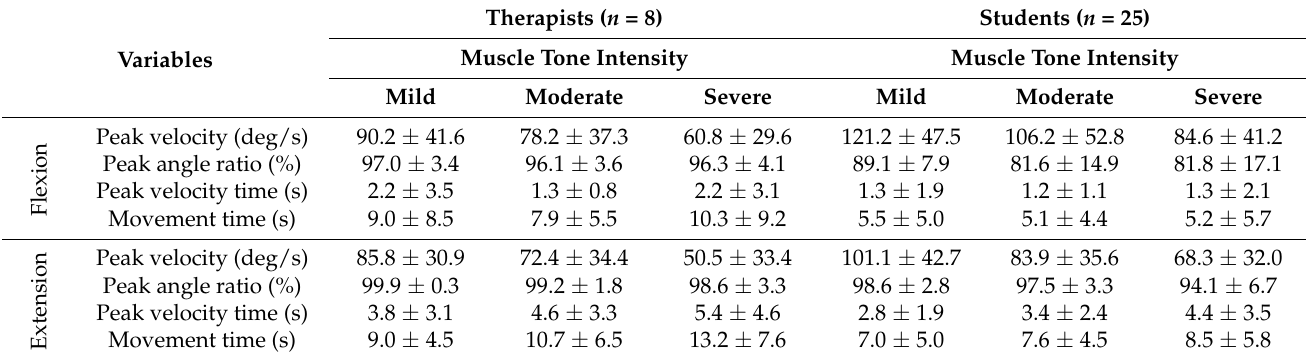
Table 2. Kinematic data of therapeutic techniques applied by students and therapists using a robot.